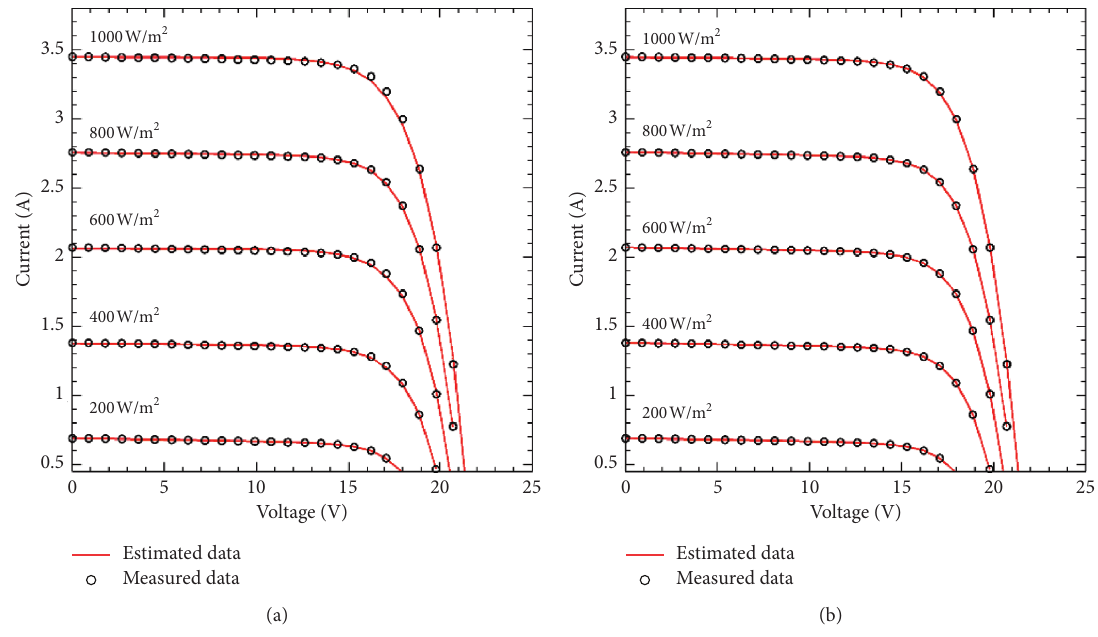
Figure 13: I-VC of (a) SDM and (b) DDM for monocrystalline SM55 at different irradiances.